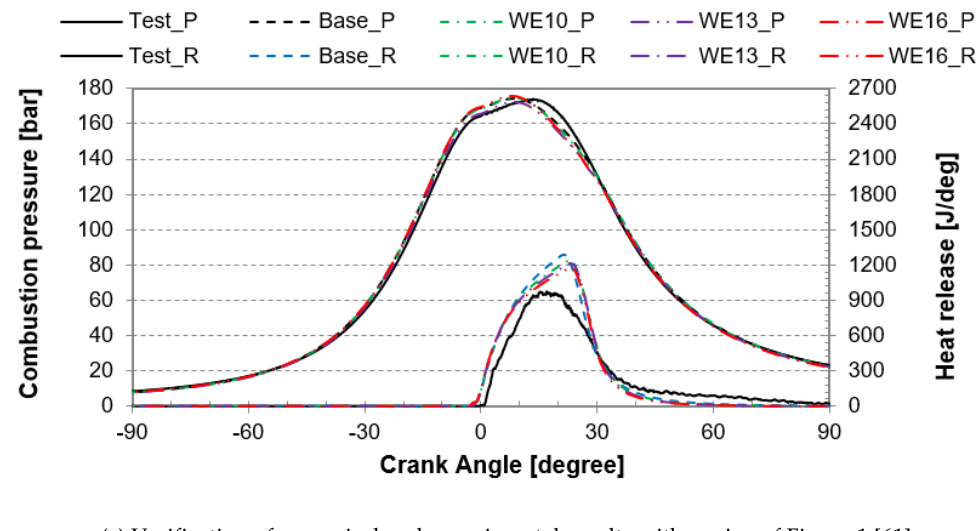
( c ) Verification of numerical and experimental results with engine of Figure 1 [61] Figure 2. AVL BOOST ™ model and turbocharger data for a four-stroke marine diesel engine. (Test: Experimental data, Base: Numerical data, P: combustion pressure, R: heat release, WE10: water emulsion including 10% of moisture concentration)